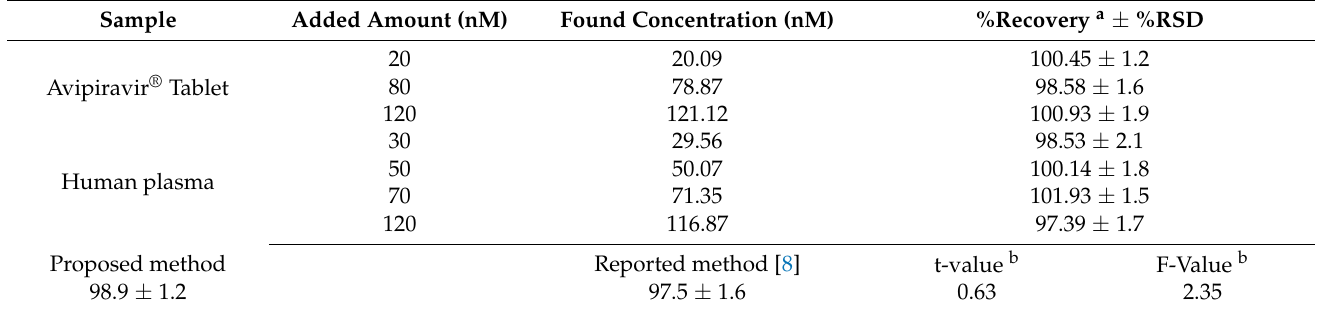
Table 4. Determination of FAV in tablets and human plasma using Tb NPS @ poly m-THB/PGE electrode.